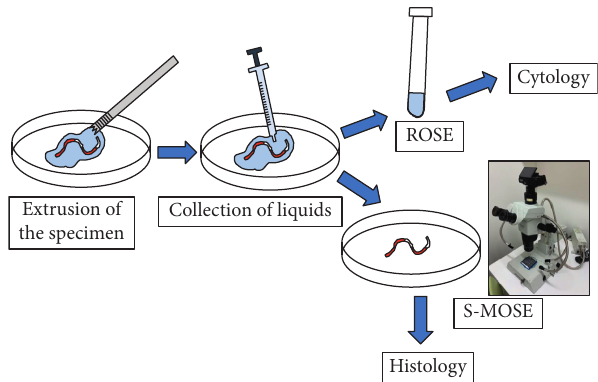
Figure 1: Specimen processing with an endoscopic ultrasound-guided fine-needle biopsy. After each pass, the specimen was extruded from the needle onto a Petri dish with saline. The liquid components around the specimen were aspirated with a syringe and submitted for rapid on-site cytopathological evaluation (ROSE) and cytology. The remaining solid specimens were immediately evaluated under a stereo- microscope and then submitted for histological examination.